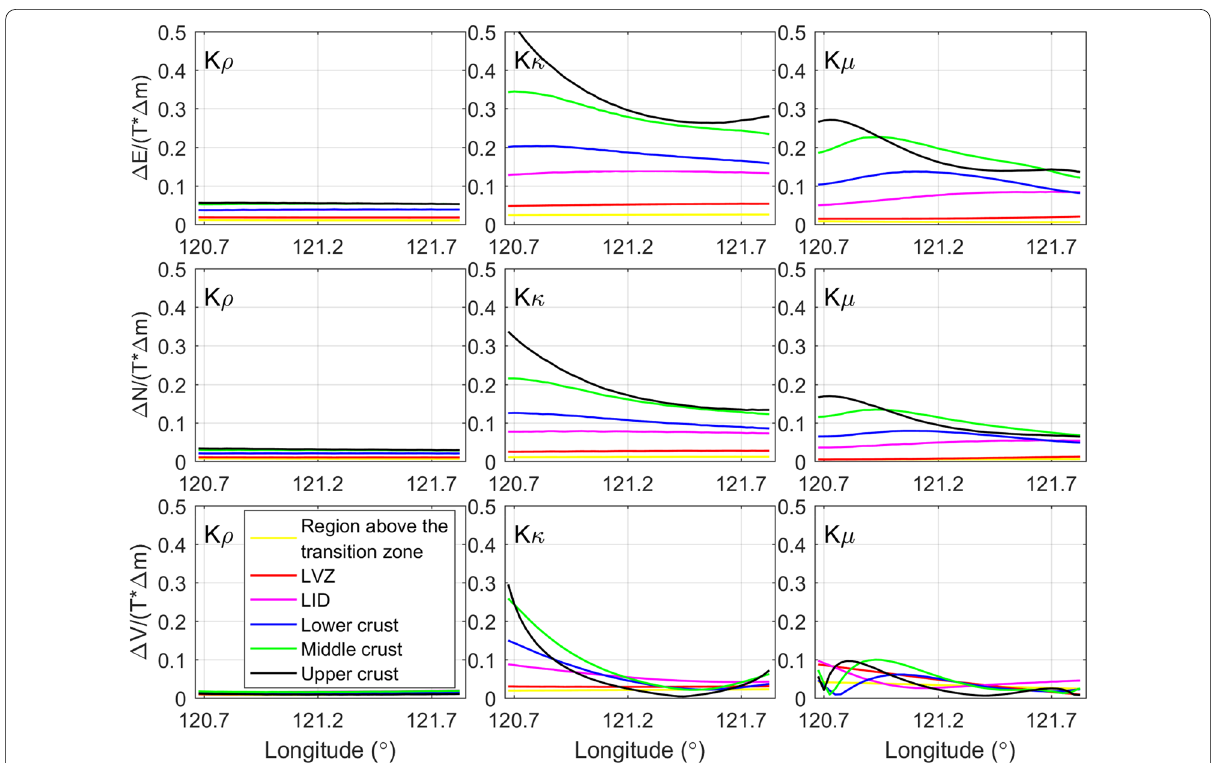
Fig. 8 Unit thickness sensitivity kernels of the modeled M 2 OTL displacements. The modeled M 2 OTL displacements are predicted at 24.5°N on Taiwan Island to 10% linear perturbations of the density (left), bulk modulus (middle), and shear modulus (right) in the upper crust (black), middle + crust (green), lower crust (blue), LID (magenta), LVZ (red), and region above the transition zone (yellow) of TW1. The depths of the perturbed layers: the upper crust (0–13.88 km depth), middle crust (13.88–24.52 km depth), lower crust (24.52–32.15 km depth), LID (32.15–80 km depth), LVZ (80–220 km depth), and region above the transition zone (220–400 km